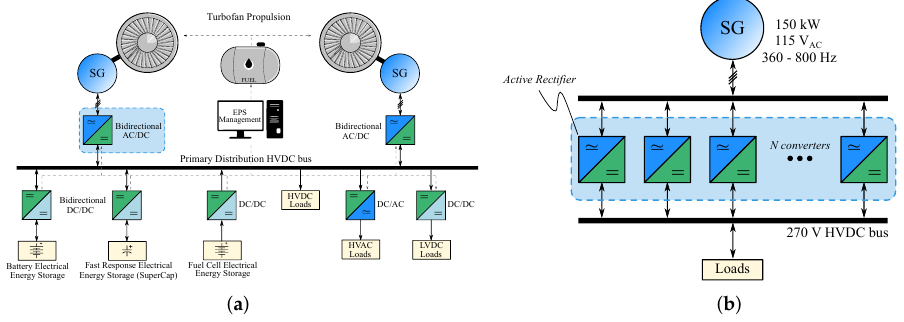
Figure 1. Examples of ( a ) a simplified electric power system architecture based on “single-bus” MEA topology, and ( b ) the proposed simplified active modular converter